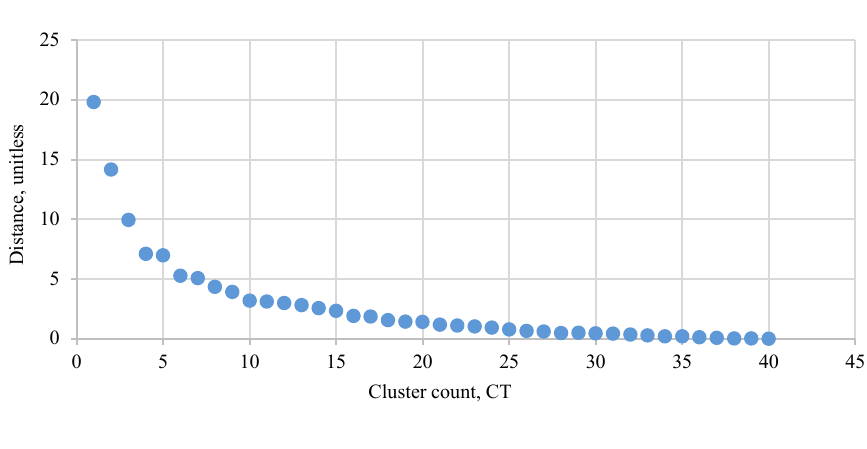
Fig. 6. Cluster combinations of hygrothermal properties data.